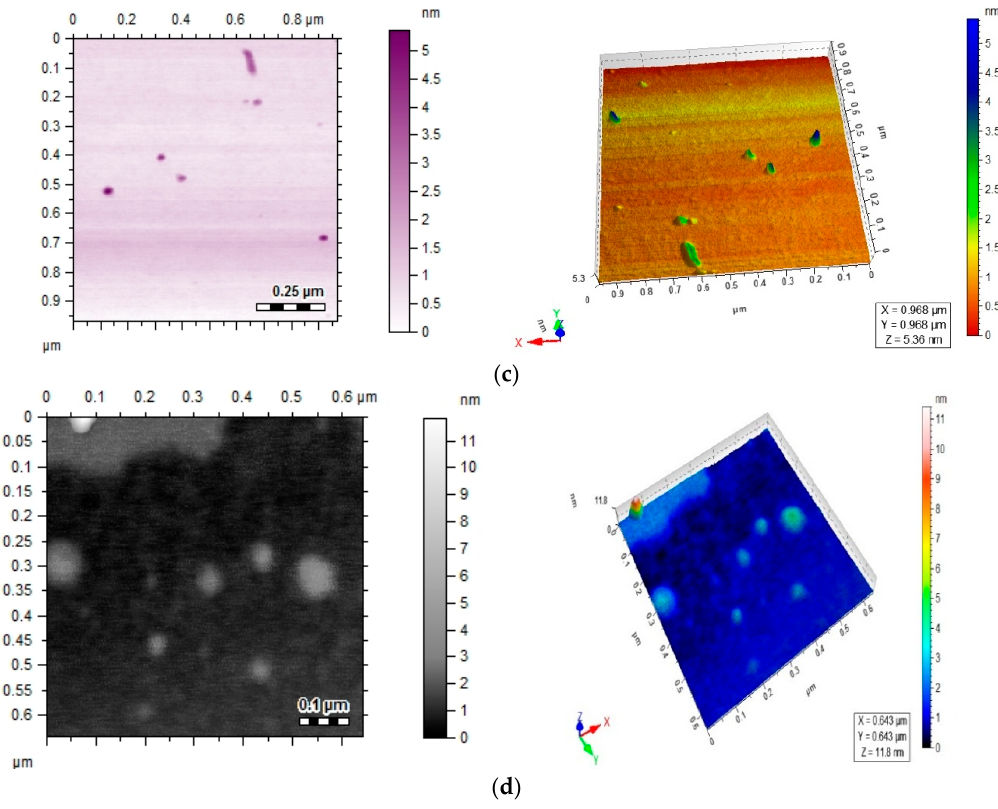
Figure 3. ( a ) FTIR spectra of Ag-cip NPs; ( b ) FTIR spectra of Au-cip NPs; ( c ) AFM image of silver nanoparticles; ( d ) AFM image of gold nanoparticles.